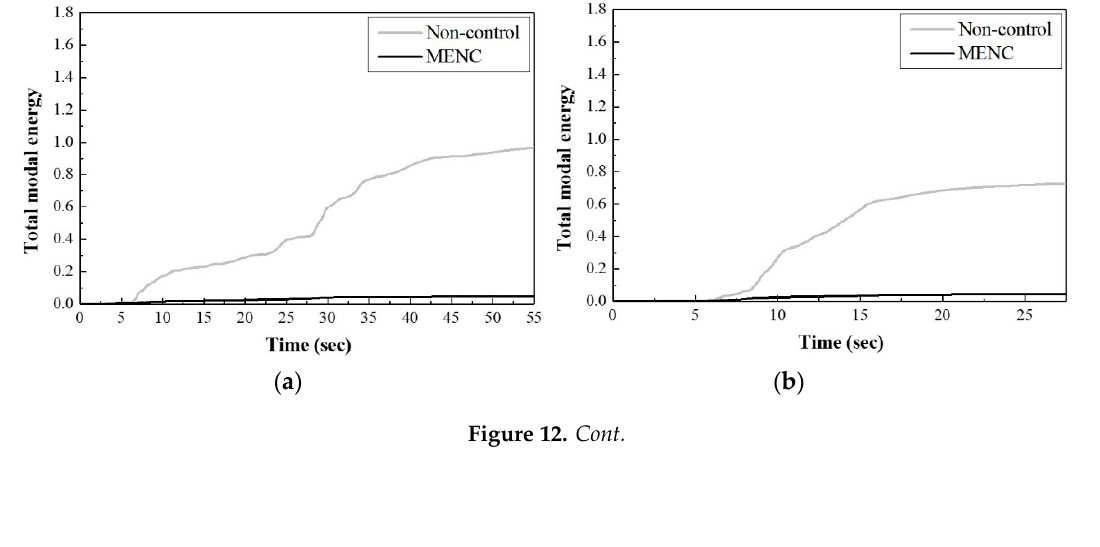
Figure 11. Comparison of modal energies in the control and non-control of the building structure under the Northridge earthquake: ( a ) first modal energy; ( b ) second modal energy; ( c ) third modal energy; ( d ) total modal energy.